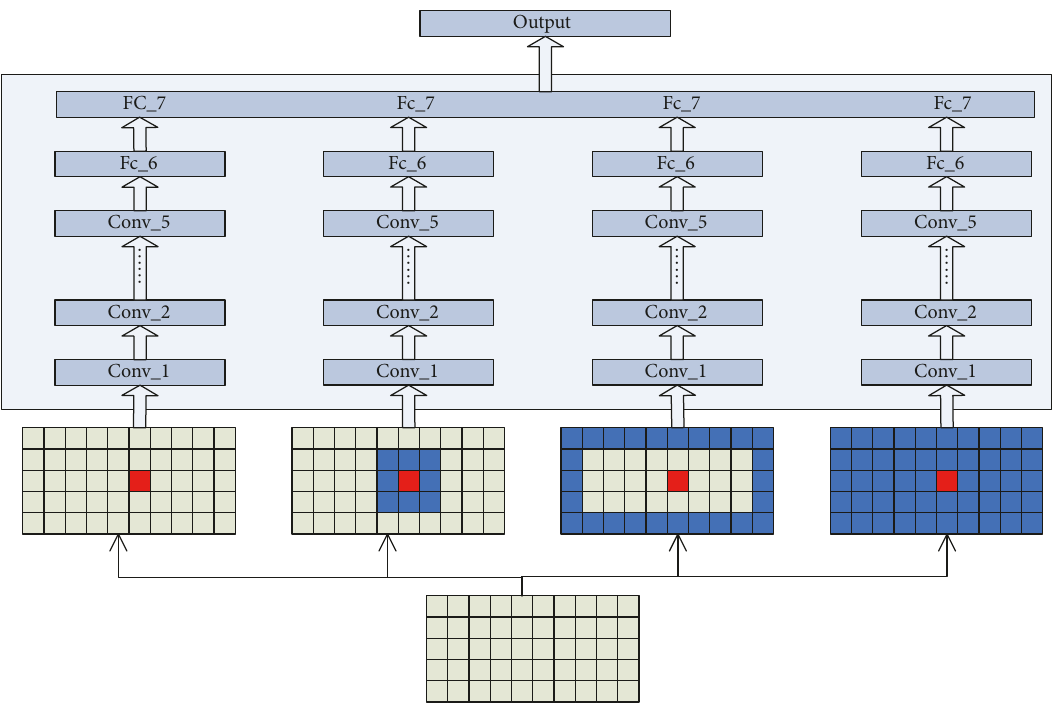
Figure 2: Architecture of network.